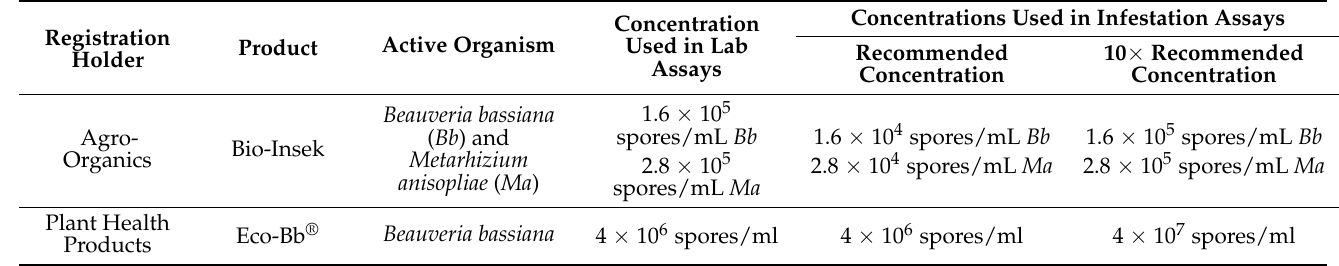
Table 1. Commercial entomopathogenic agents and the concentrations at which they were used in this